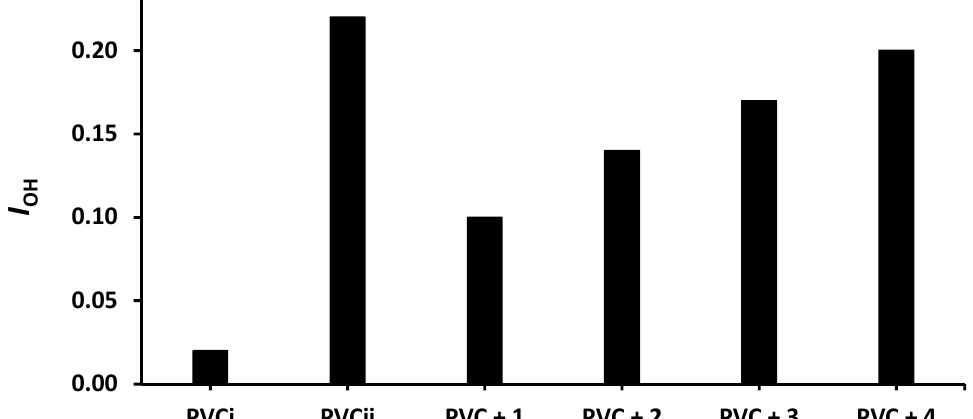
Figure 4. Effect of irradiation (300 h) on the index of the OH group ( I OH ) of PVC films containing tin(IV) compounds 1 – 4 . PVC i and PVC ii are the I OH of the blank PVC film before and after irradiation, respectively.